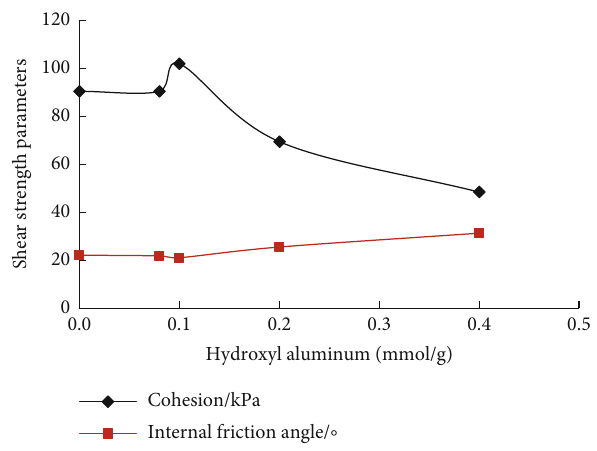
Figure 10: The adhesive force and internal friction angle change with aluminum compound content of modi fi cation clay